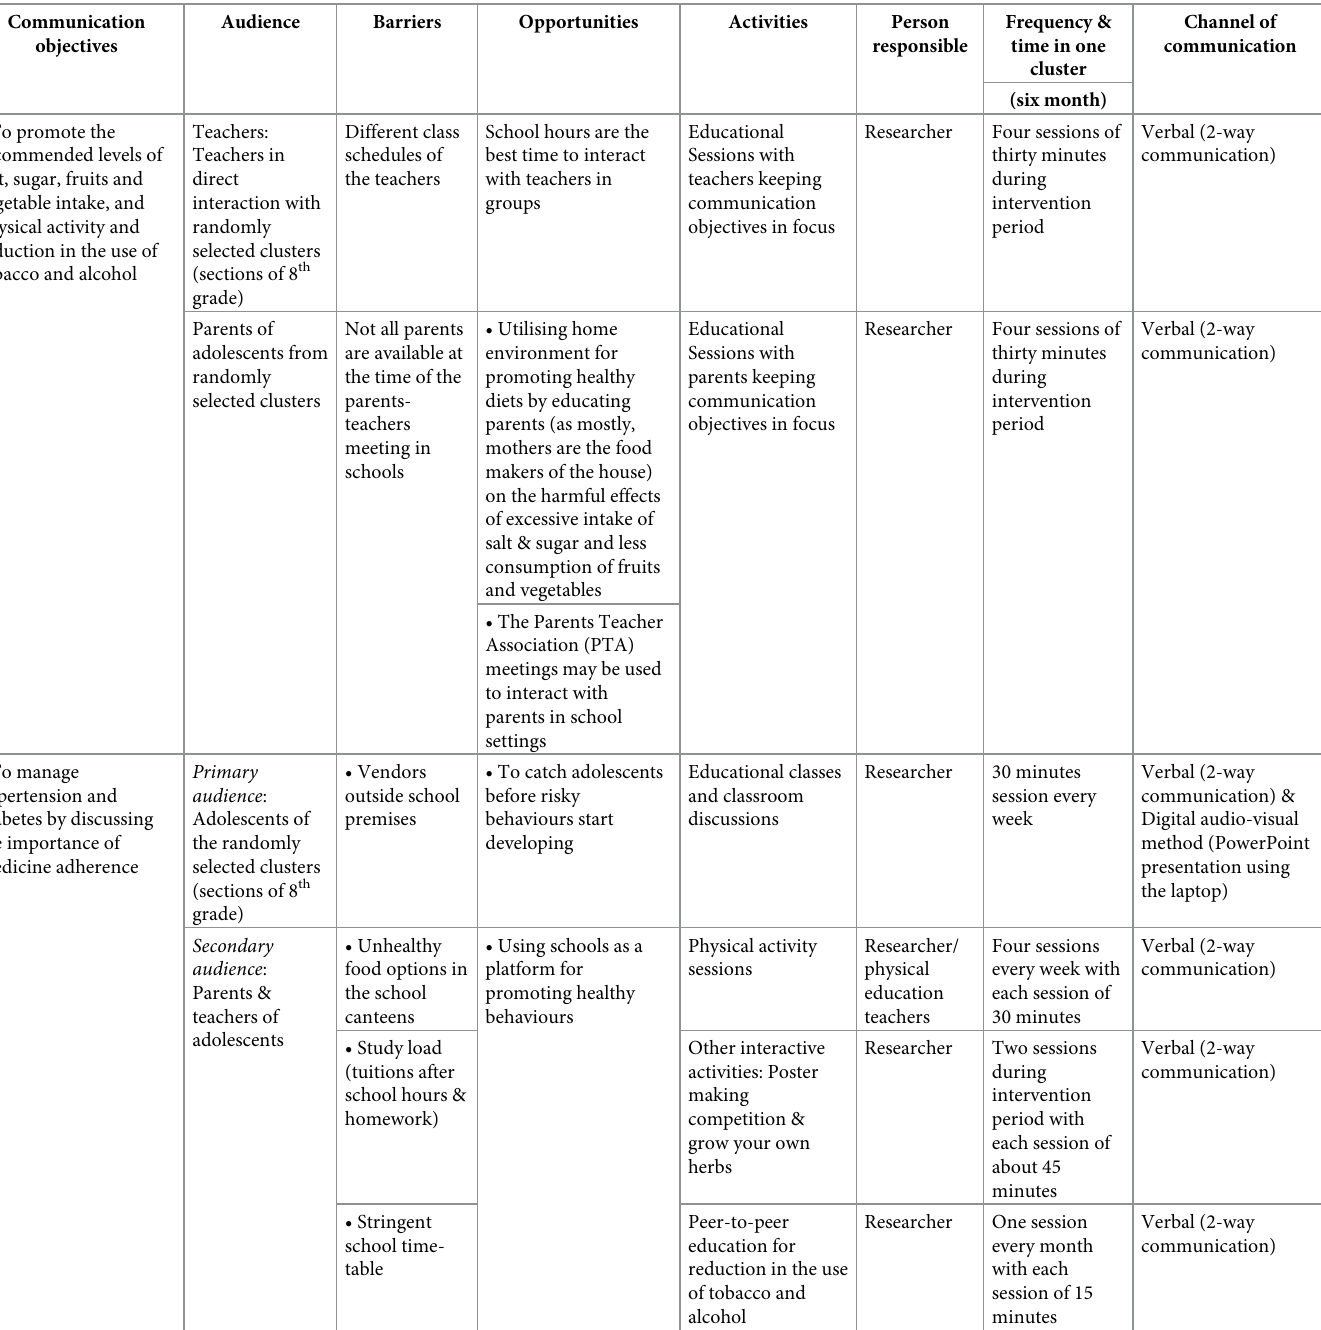
Table 2. Behaviour change communication matrix for health promotion interventions to reduce chronic disease risk factors in public schools in Chandigarh, India. Communication objectives